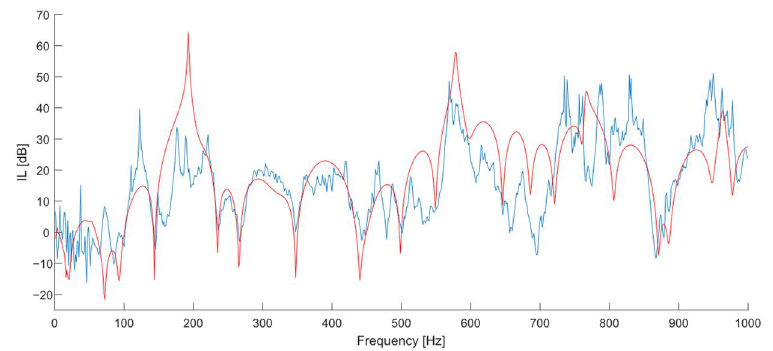
Figure 17. Comparison between the predicted IL (red) and the measured IL (blue).